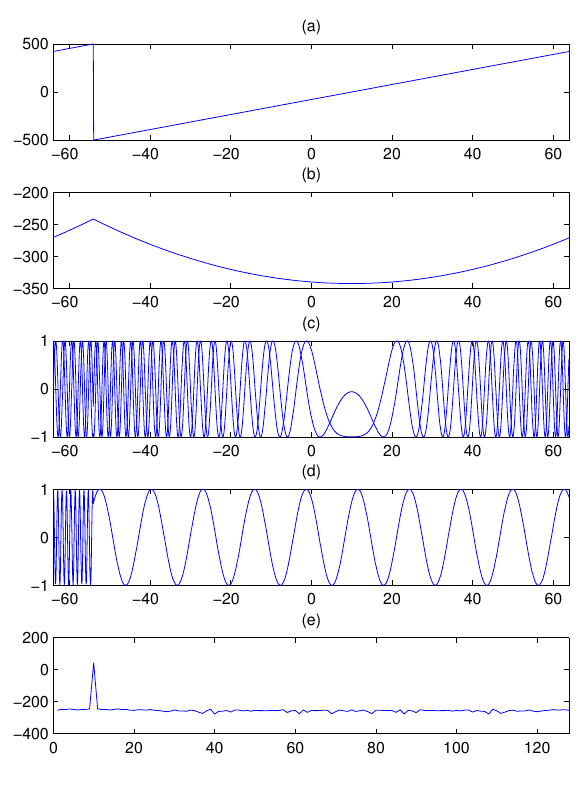
Figure 4. Coded chirp : SF = 2 7 , raw chirp shifted by